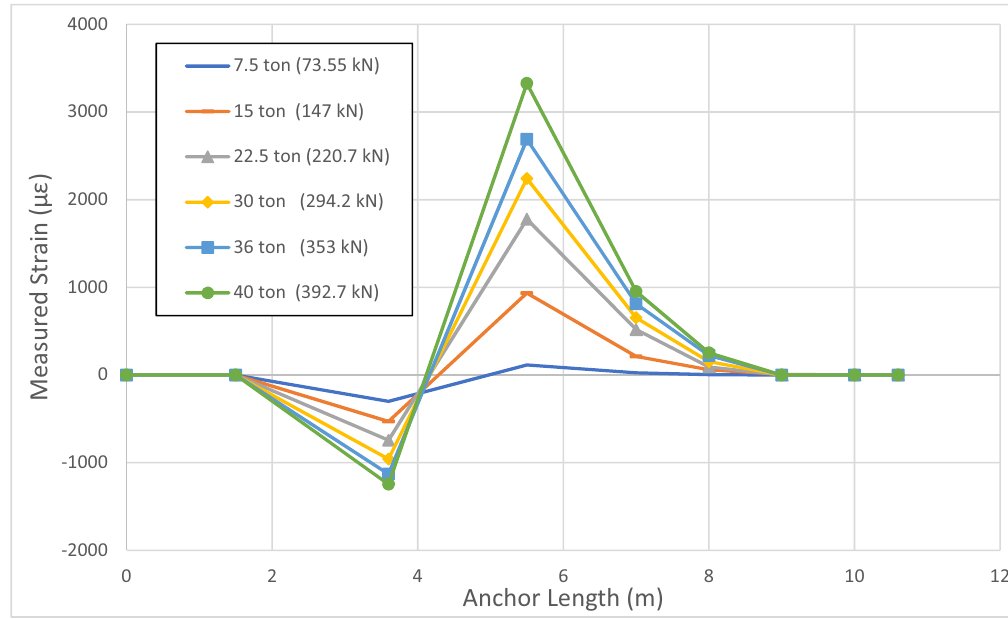
Figure 17: Measured strains along the grouted body of anchor 1, starting from the ground